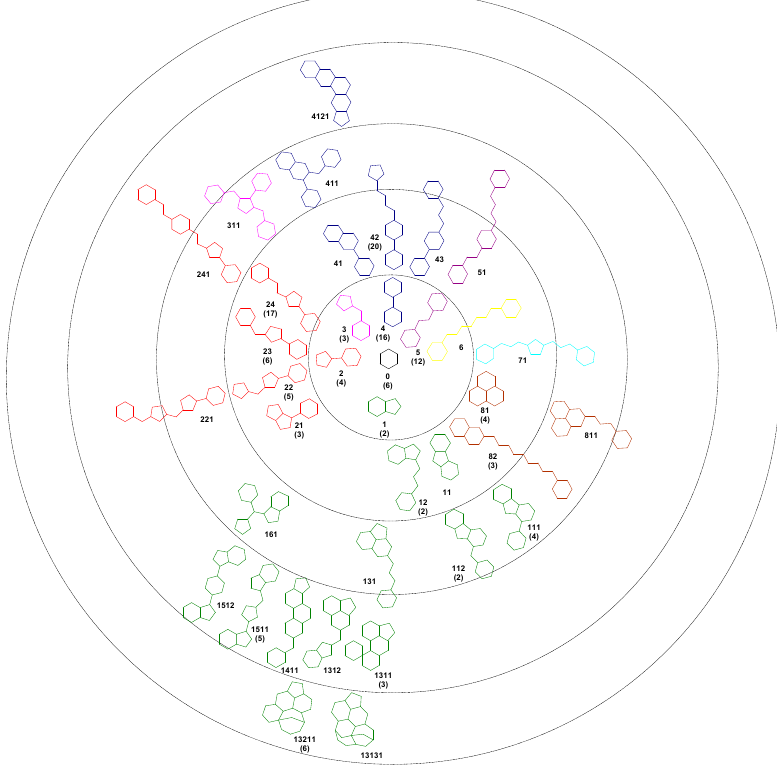
Figure 1. Bemis-Murcko scaffolds clustering for SrtA inhibitors, in brackets the number of compounds in the 1A set.